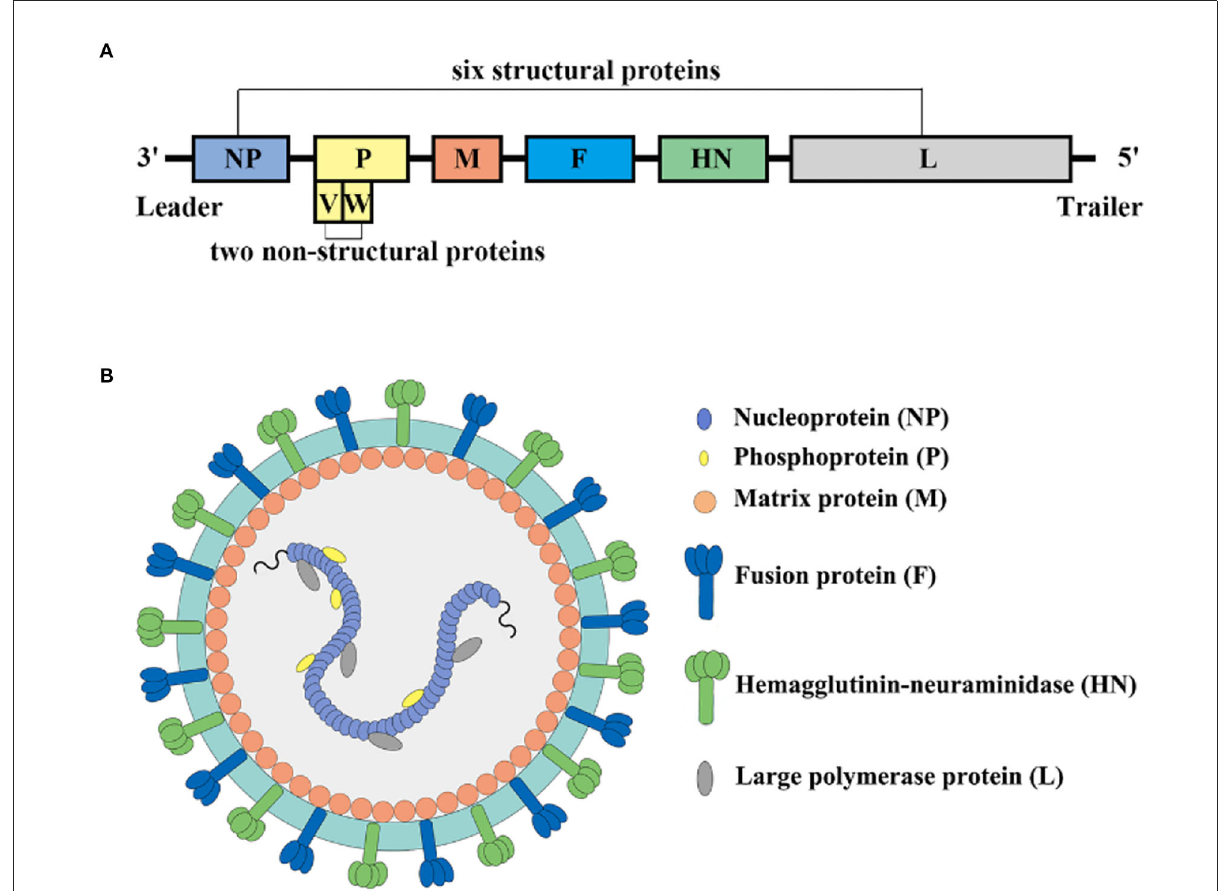
FIGURE2 (A) Schematic diagram of NDV genome; (B) Schematic diagram of NDV structure.